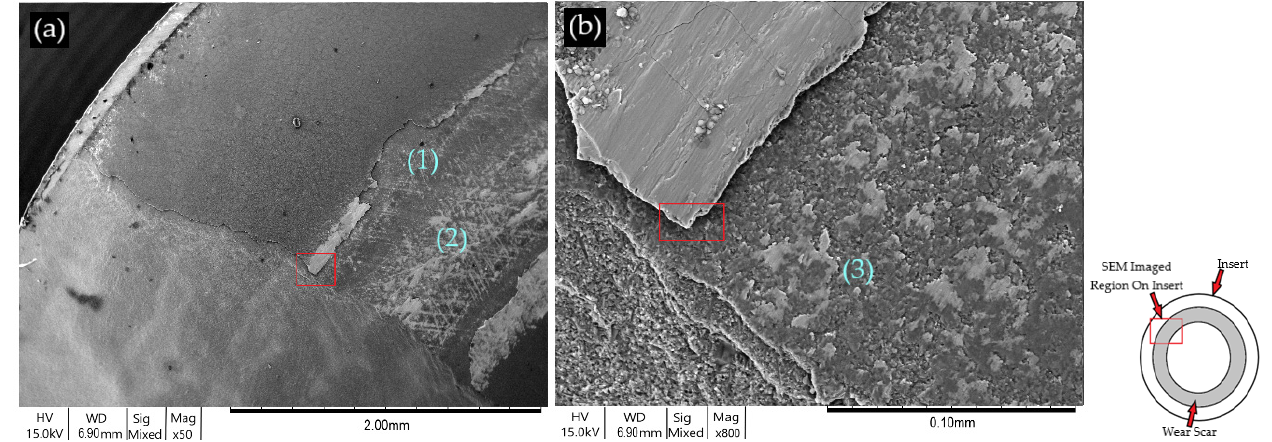
Figure 10 . SEM images of Coating A after pin-on-disc Test 2a: ( a ) ×50 magnification, ( b ) ×800 magnification.